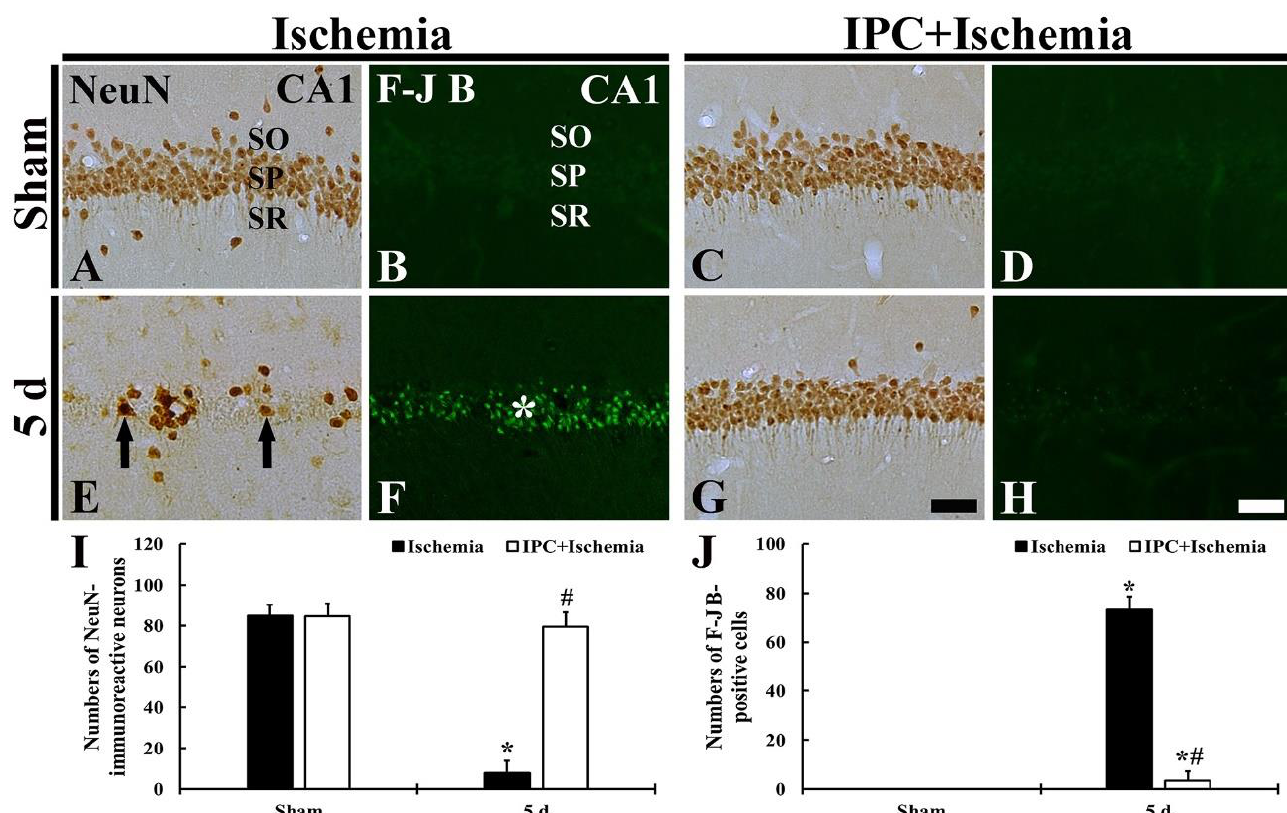
Figure 2. ( A – H ) Immunostaining of NeuN ( A , C , E , G ) and F-J B histofluorescence ( B , D , F , H ) in CA1 of the sham ( A , B ), TI ( C , D ), IPC+sham ( E , F ), and IPC+TI ( G , H ) groups at 5 days after TI. A few NeuN + cells (arrows in ( E )) are found in the stratum pyramidale (SP) of the TI group. In the IPC+TI group, however, the immunostaining of NeuN is similar to that in the sham. Many F-J B + CA1 pyramidal cells (white asterisk in ( F )) are detected at 5 days post-TI, however, F-J B + cells are hardly shown. SO, stratum oriens; SR, stratum radiatum. Scale bar = 50 µm. ( I , J ) Mean numbers of NeuN + ( I ) and F-J B + ( J ) CA1 pyramidal neurons in the SP. The bars indicate the means ± SD ( n = 7, * p < 0.05 versus sham; # p < 0.05 versus TI group).